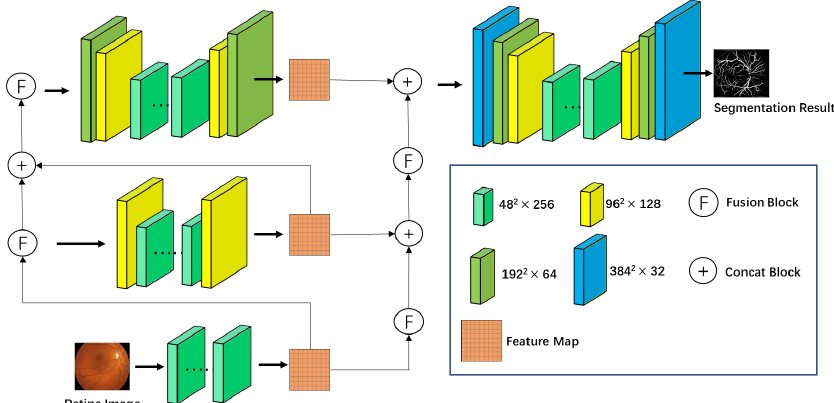
Figure 2. Pre-training network data flow